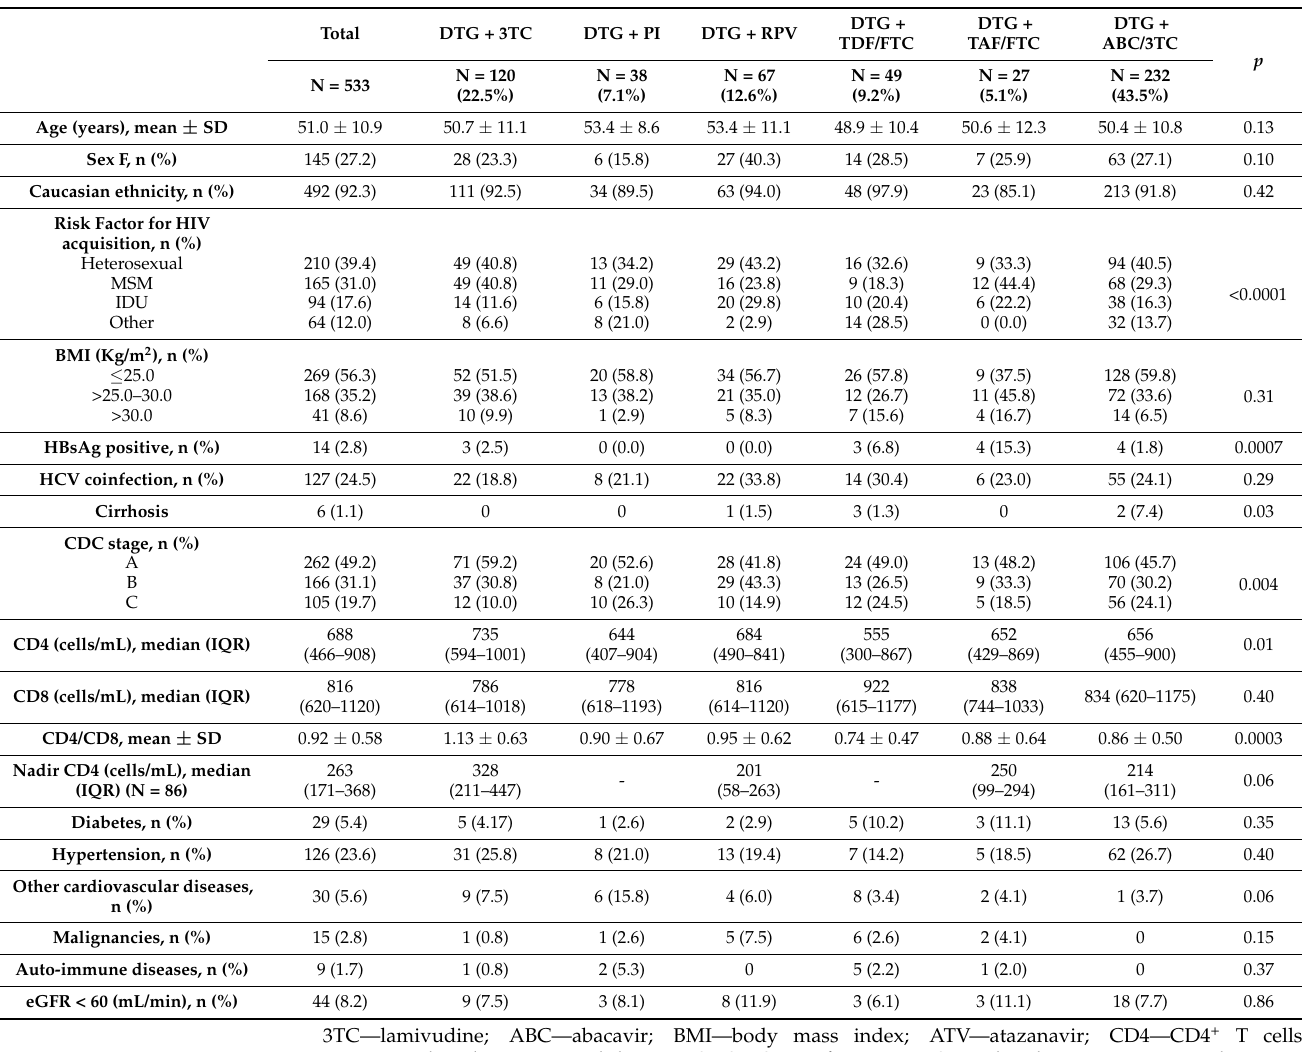
Table 1. Baseline characteristics of 533 people living with HIV (PWH) enrolled in Dolutegravir (DTG) cohort.